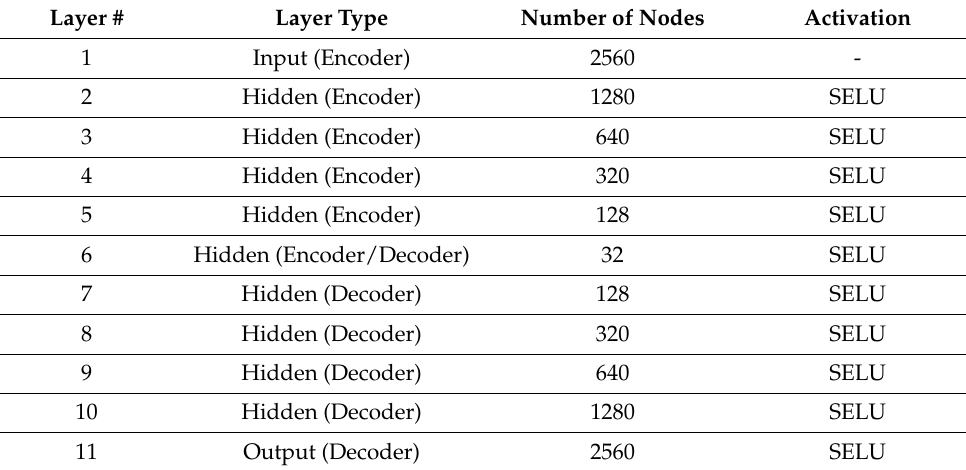
Table 3. The structure of the designed deep autoencoder